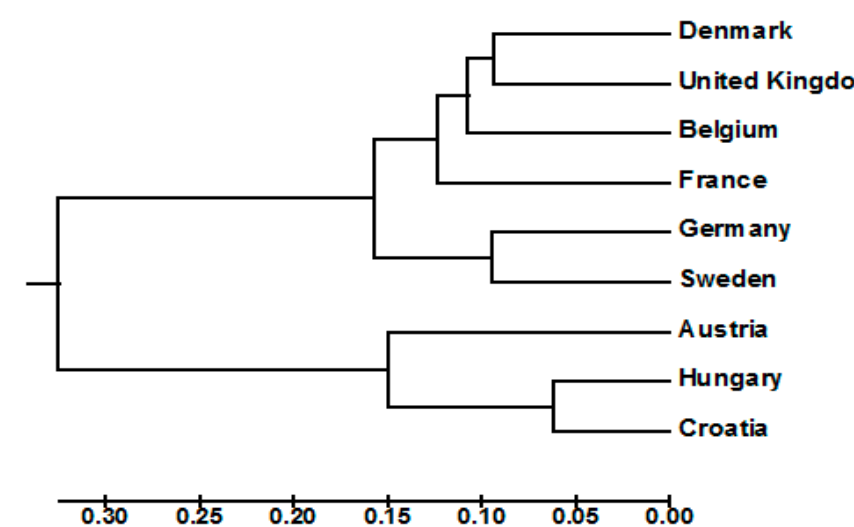
Figure 5. Unweighted pair group method with arithmetic mean (UPGMA) phylogenetic tree based on the genetic differentiation ( F ST ) values between countries.